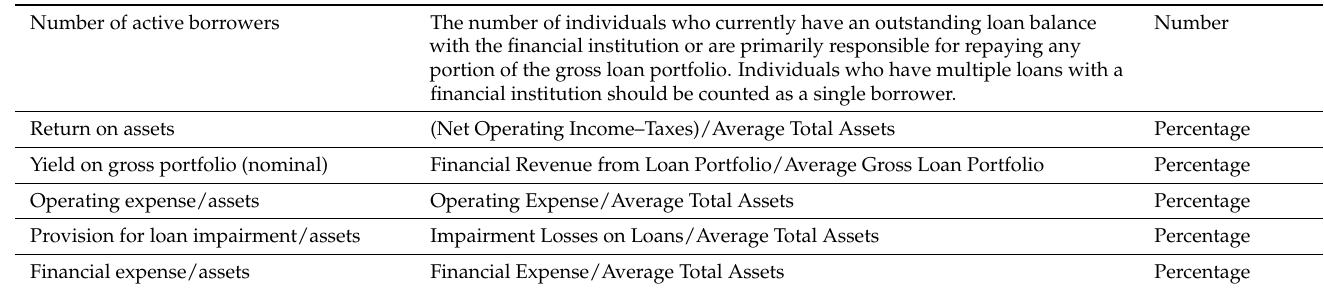
Table A1. Definition of Performance Indicators given by Microfinance Information Exchange (MIX).